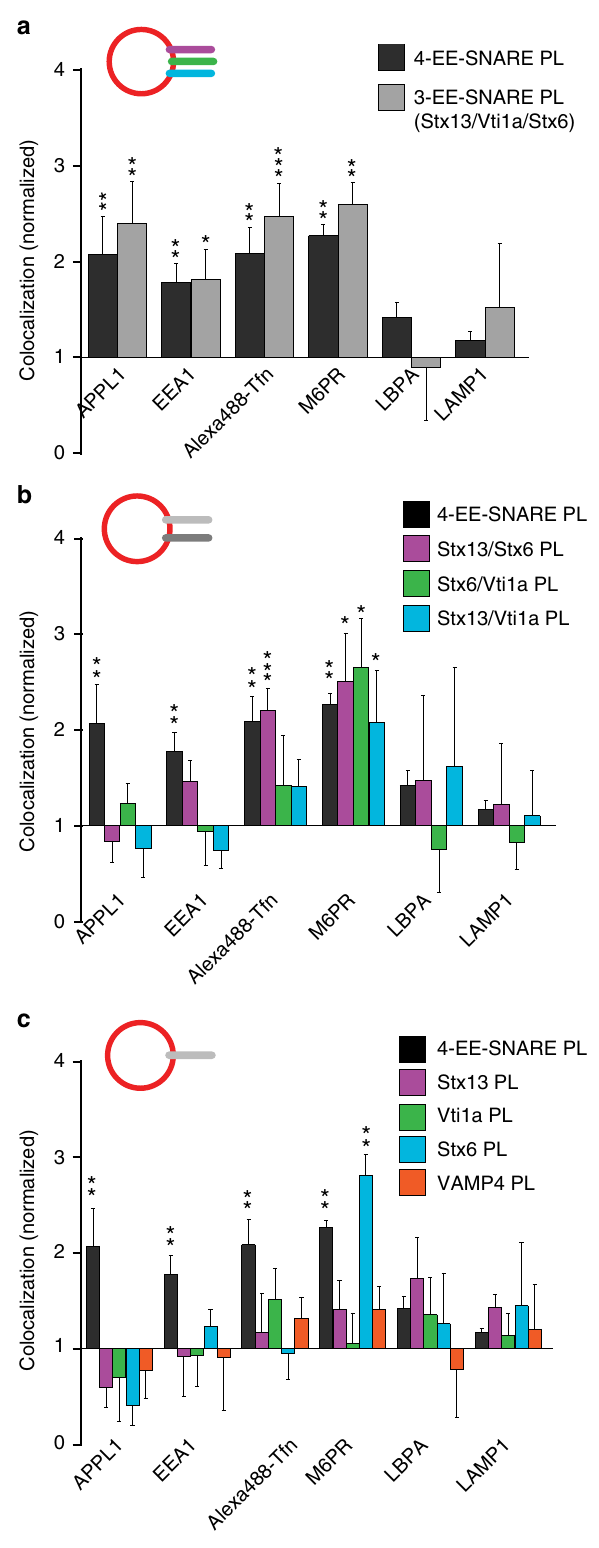
The N-terminal domain of Stx6 mediates targeting by Vps51 . To clarify whether the N-terminal domain of Stx6 is required for targeting of the liposomes to the M6PR compartment, we injected liposomes containing an N-terminally truncated mutant of Stx6